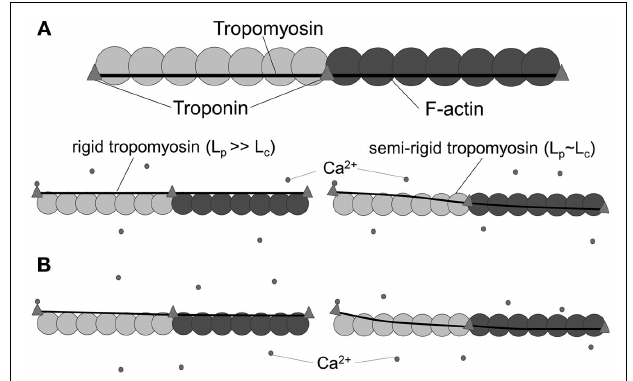
shading, are shown from each thin filament). In contrast, for semi-flexible ( L p ∼ L c ) tropomyosin (middle right), only a portion of the strand moves azimuthally and just 1–2 SRUs are activated. (B) Reduction in rigidity of an initially rigid tropomyosin has little impact on thin filament activation (bottom left), as activation signal still propagates along multiple SRUs. In contrast, a reduction in rigidity of a semi-flexible tropomyosin (bottom right) will significantly reduce the effective propagation length of activation signal, but also increases the likelihood of activation at lower Ca 2 +